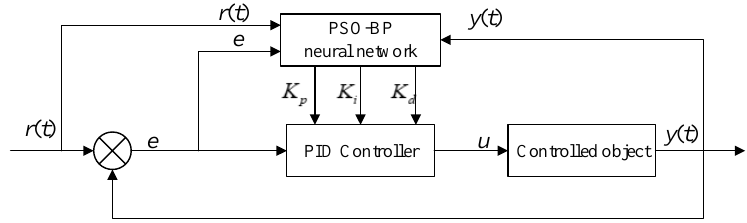
Figure 6. A PID control system diagram based on the PSO-BP neural network.